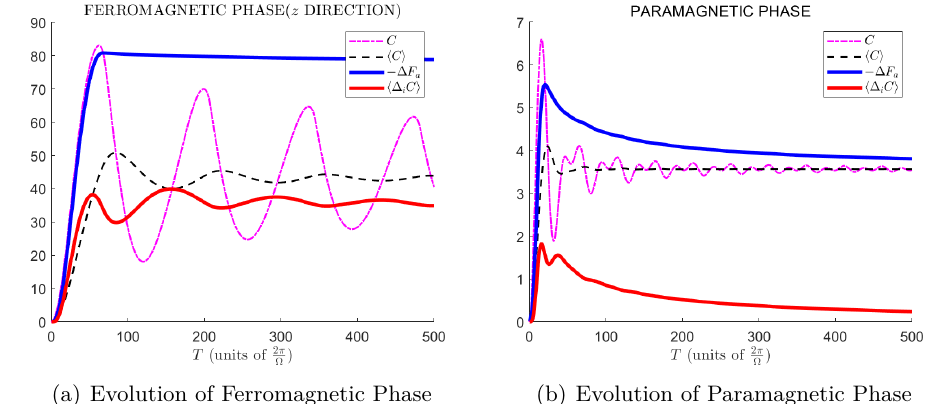
Figure 6 . Here C , h C i , ∆ F a and h ∆ i C i represent complexity, average complexity, the computational free energy difference and the average cumulative complexity production, respectively, and the parameters are set to η = 1 , N = 1000 , l = 2 , J = 0 . 01Ω , g to the ferromagnetic phase along the z direction and the paramagnetic phase,